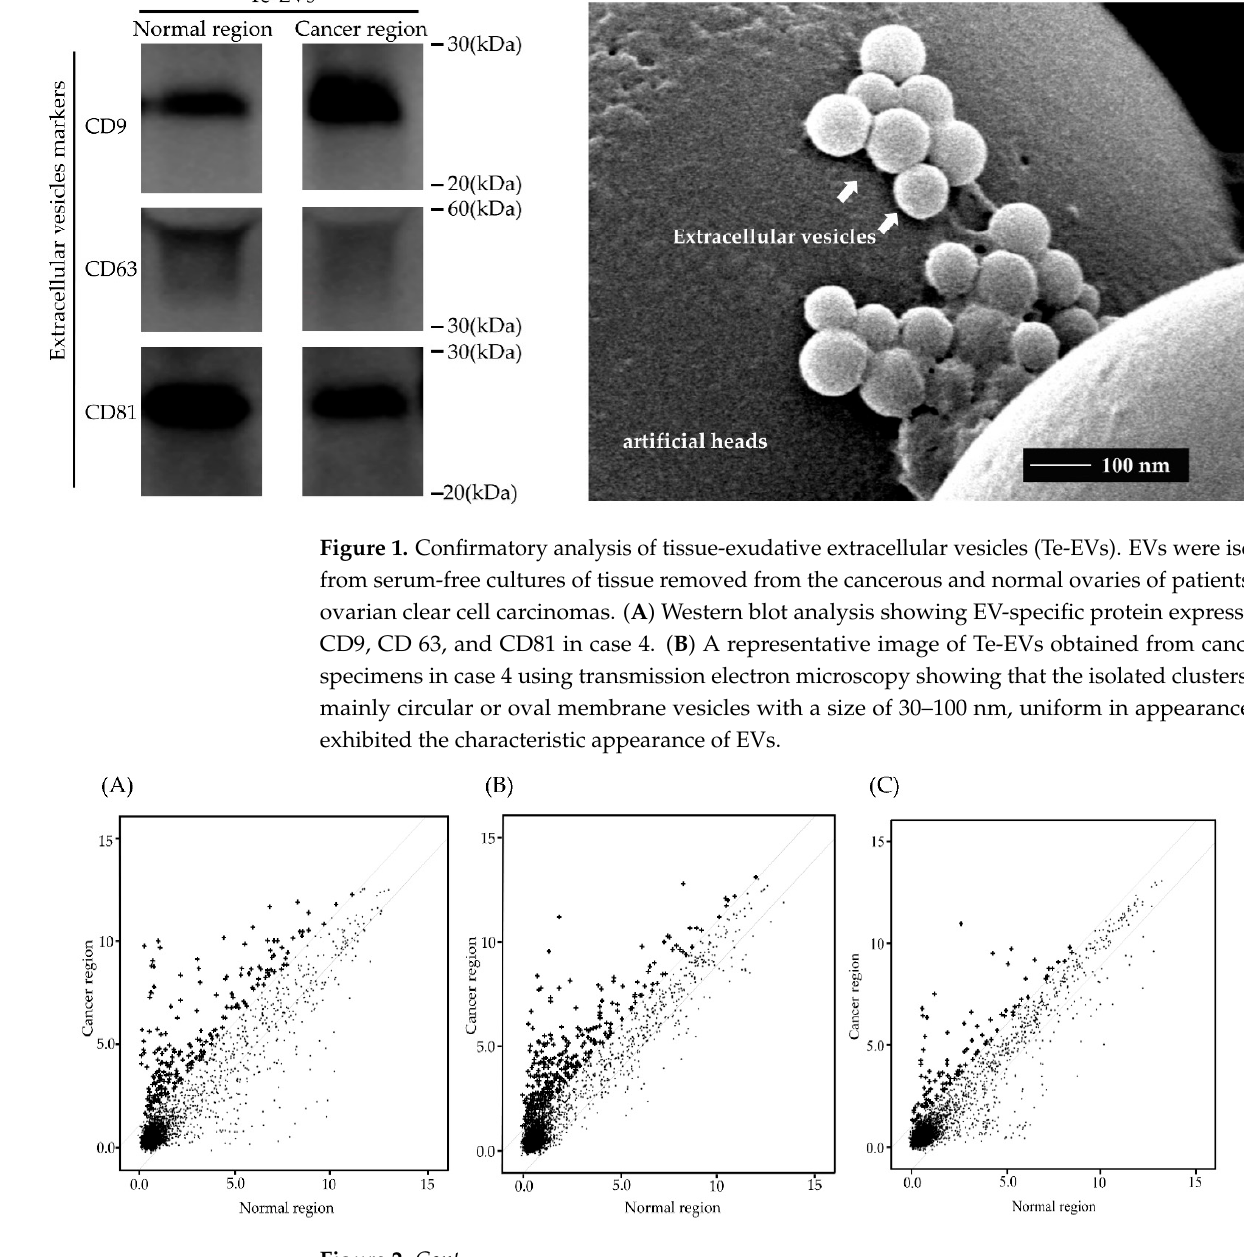
Figure 2. MiRNA microarray analysis was performed to Te-EVs obtained from OCC specimens and normal ovaries. Scatter plot of miRNA signal values showing the miRNA expression variation be- tween the cancerous and normal samples. The values spotted in the x- and y-axes represent the normalized signals of samples in the two groups (log2-scaled). The solid lines represent fold changes. The miRNAs above the upper solid line and below the lower solid line are those with a > 2-fold change in expression levels between the cancerous and normal-appearing tissues. The cross marks indicate that the miRNAs are two-fold or higher overexpressed in the cancerous region com- pared with the normal region. ( A ) 255 miRNAs were detected in case 1. ( B ) 342 miRNAs were de- tected in case 2. ( C ) 90 miRNAs were detected in case 3. ( D ) 272 miRNAs were detected in case 4. ( E ) 37 miRNAs were detected in all four cases.